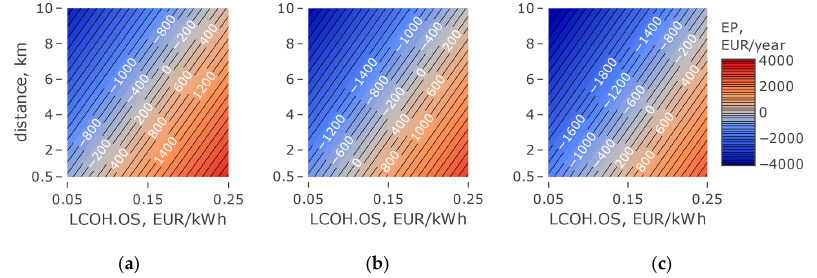
Figure 13. The Yearly Economical Profitable as a function of Levelized Cost of Heating from non-geothermal source (LCOH.OS) and distance between Geothermal Base Station and House, for Total Heat Demand (THD) = 15,000 kWh/year and for: ( a ) M-TES price = 2000 EUR; ( b ) M-TES price = 6000 EUR; ( c ) M-TES price = 10,000 EUR.